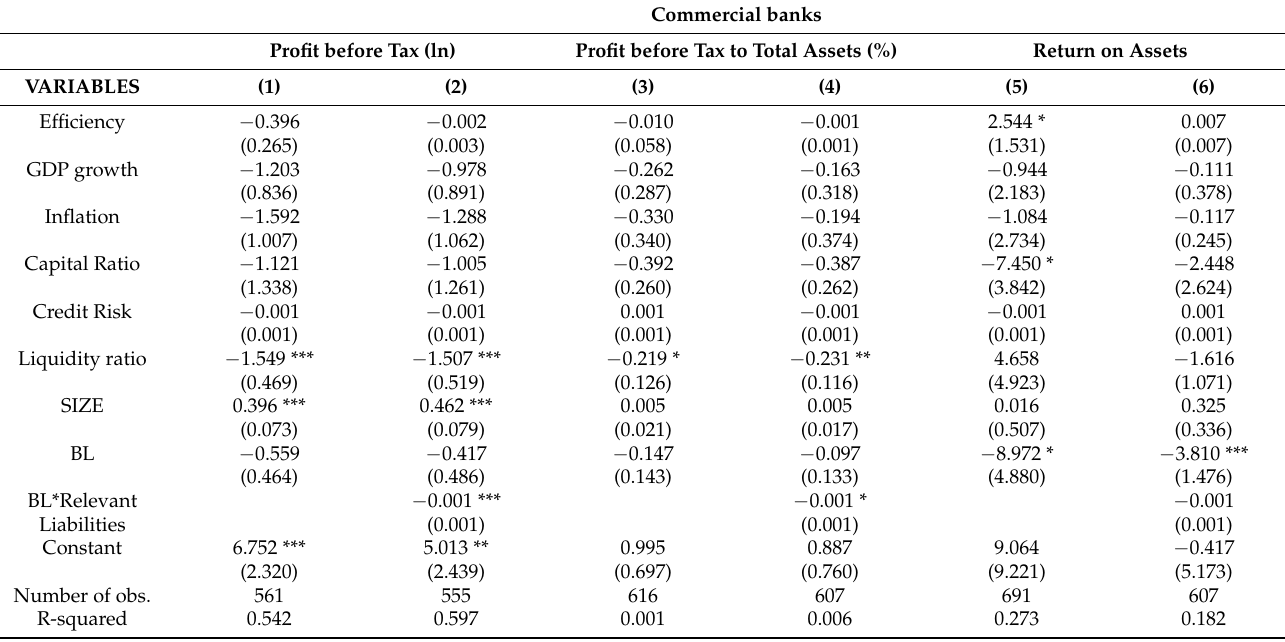
Table A4. Data presenting estimates based on GLS regressions with a random effect on German commercial banks. Symbols *, **, and *** represent statistical significance at the levels of 10%, 5%, and 1%, respectively.